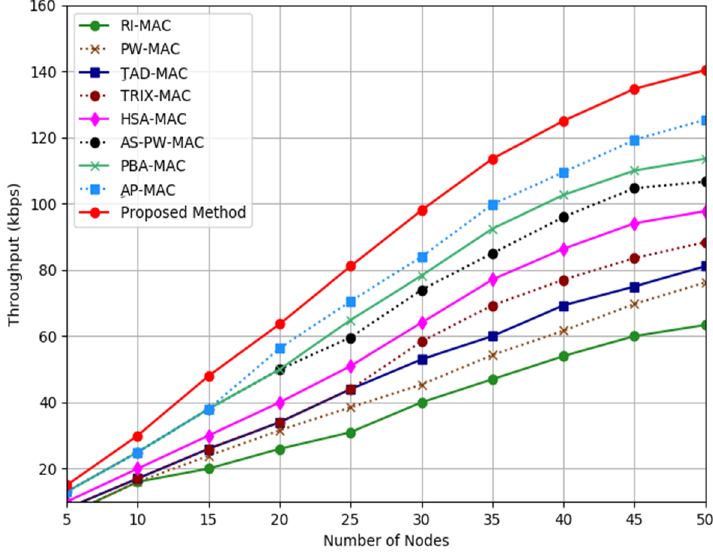
Figure 5. Throughput Figure 6. Throughput analysis.